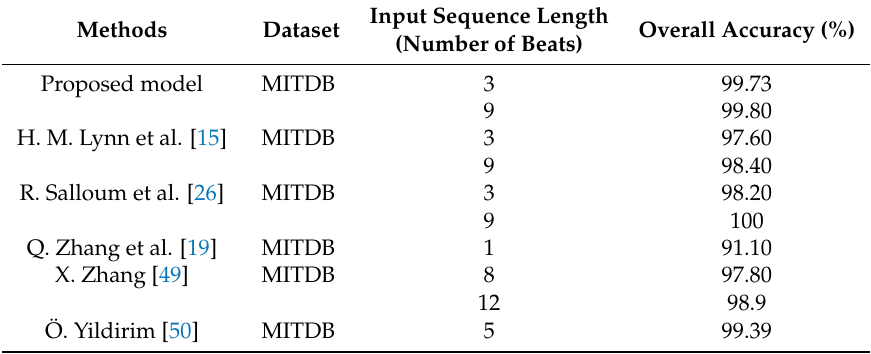
Table 9. Performance comparison with state-of-the-art